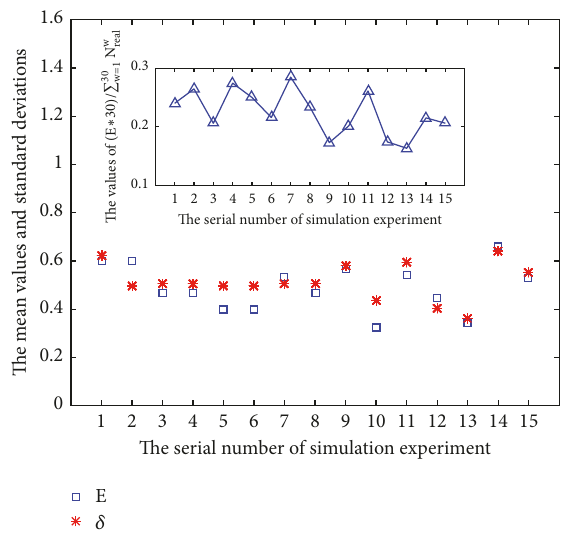
Figure 20: The values E and 𝛿 of |𝑁 𝑤 𝑟𝑒𝑎𝑙 − 𝑁 𝑤 𝑠𝑖𝑚𝑢𝑙𝑎𝑡𝑖𝑜𝑛 | at 30 waiting areasfor Shanghai naturalhistorymuseumstation with JinyunRoad